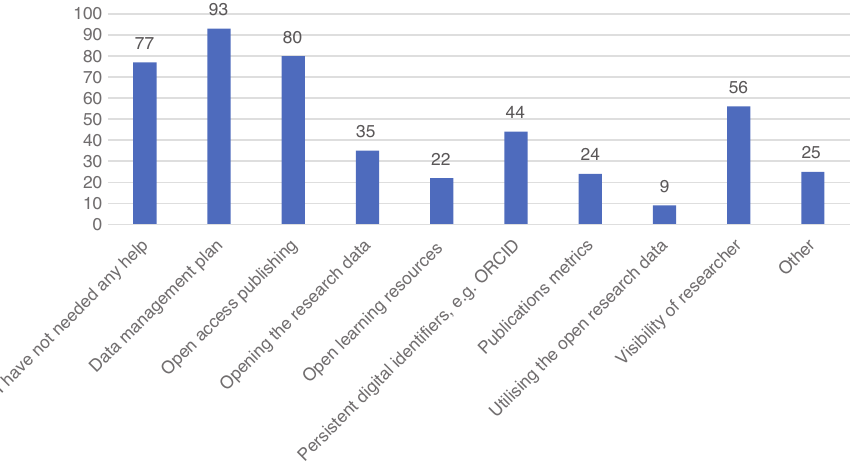
Fig. 10: Help services by themes (N=261